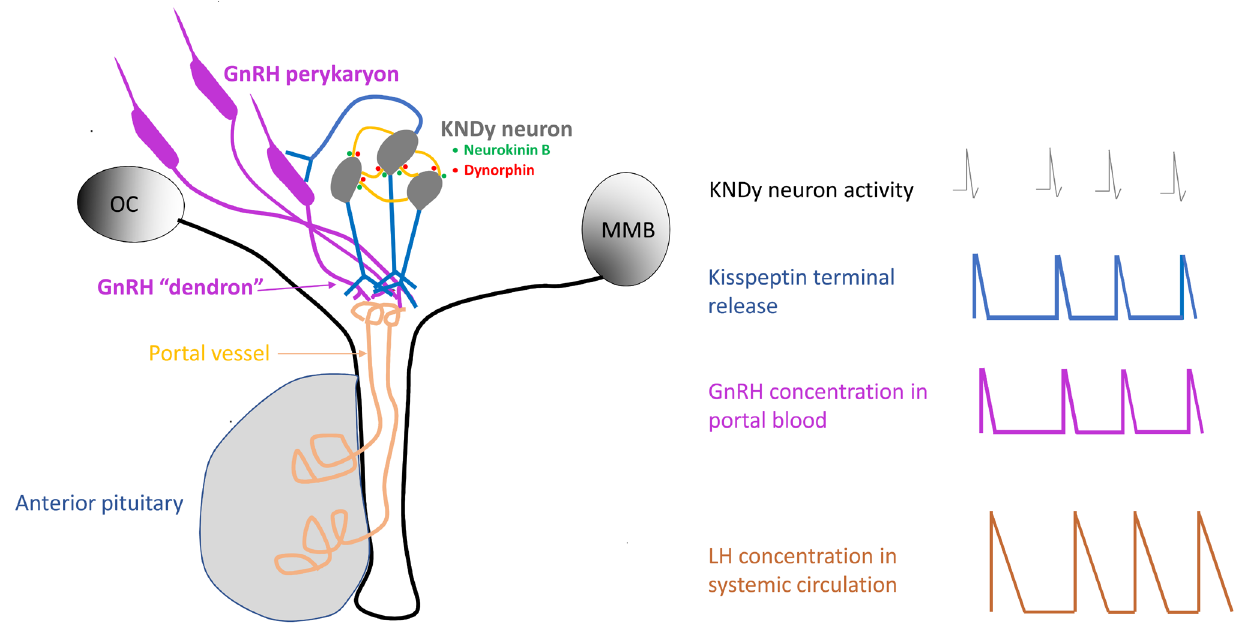
Figure 6. Simple schematic of the KNDy neuron model of the GnRH pulse generator. Small green and red filled circles indicate neurokinin B and dynorphin auto-synaptic release, respectively, within the arcuate nucleus. The temporal dynamics of the release of these two neuropeptides at this location are unknown. GnRH, gonadotropin-releasing hormone; MMB, mammillary body; OC, optic